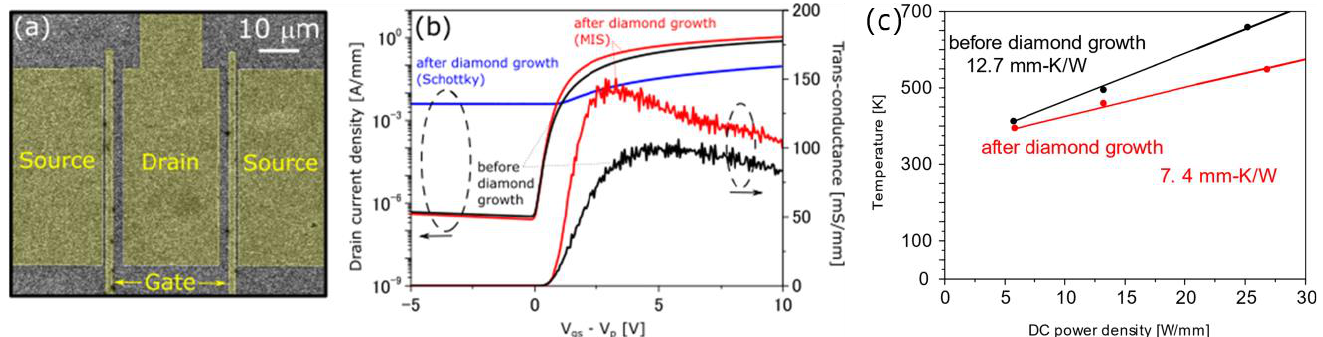
Figure 13. ( a ) SEM image of diamond films grown on GaN HEMTs. ( b ) Transfer curve and transconductance versus gate voltage. ( c ) Channel temperature calculated from the Raman peak shift [131].